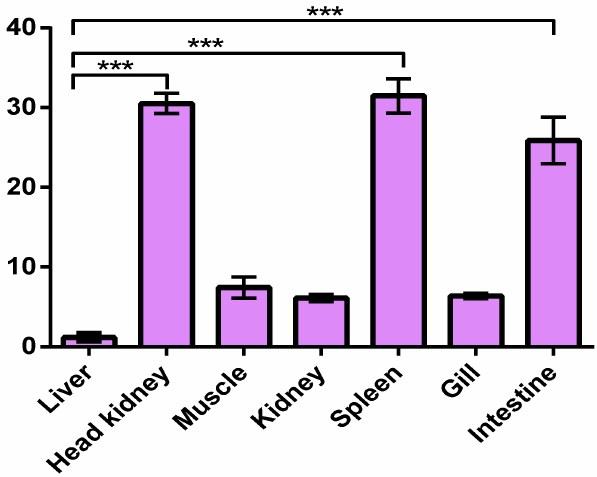
Figure 3. The expression level of maNramp mRNA in different tissues from healthy M. amblycephala . β -actin gene was used as a reference gene to normalize the expression level. The vertical axis indicated that maNramp mRNA expression was relative to that of liver (fold). Significant pairwise expression-level differences between different tissues were indicated by different asterisks. Three asterisks (***) represented p < 0.001.